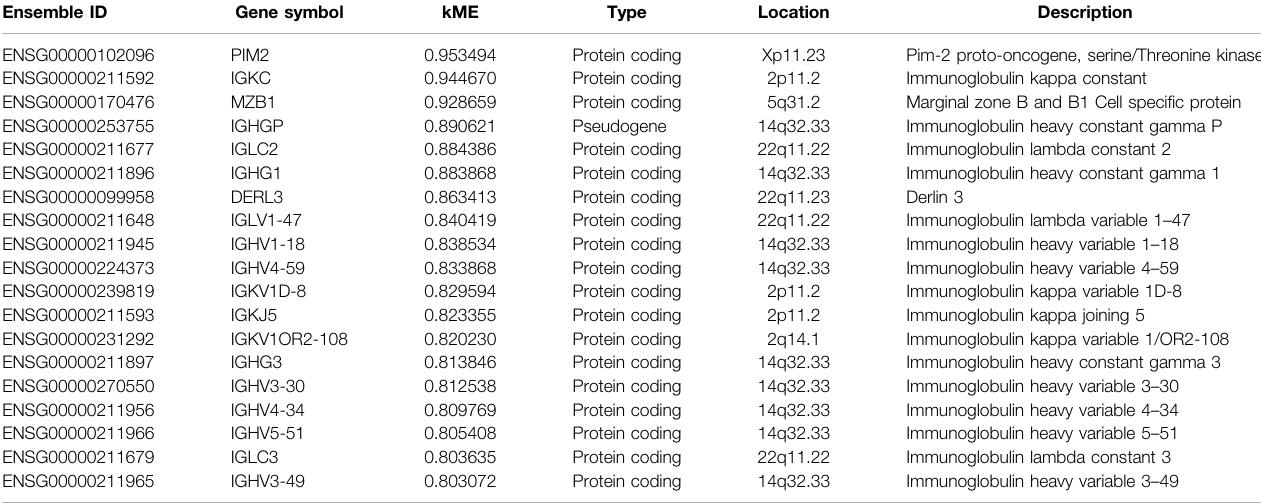
TABLE 2 | RR module gene (kME > 0.8) from WGCNA.